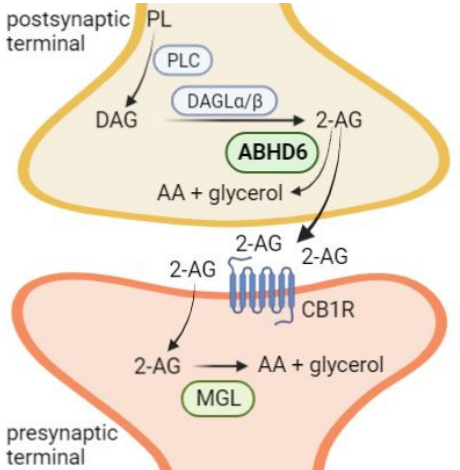
Figure 5. ABHD6 in endocannabinoid signaling. 2-arachidonoylglycerol (2-AG) is synthesized on membranes of postsynaptic neuron terminals by the degradation of phospholipids by phospholipase C (PLC) generating diacylglycerol (DAG). These are hydrolyzed by diacylglycerol lipase (DAGL) α and DAGLβ to form 2-AG. 2-AG is then either hydrolyzed by α/β-hydrolase domain-containing 6 (ABHD6) to arachidonic acid (AA) and glycerol or released from the cell. On postsynaptic neurons, 2-AG activates cannabinoid receptor 1 (CB1R) and is subsequently hydrolyzed by monoglyceride lipase (MGL) to AA and glycerol, terminating endocannabinoid signaling. Figure was generated using BioRender.